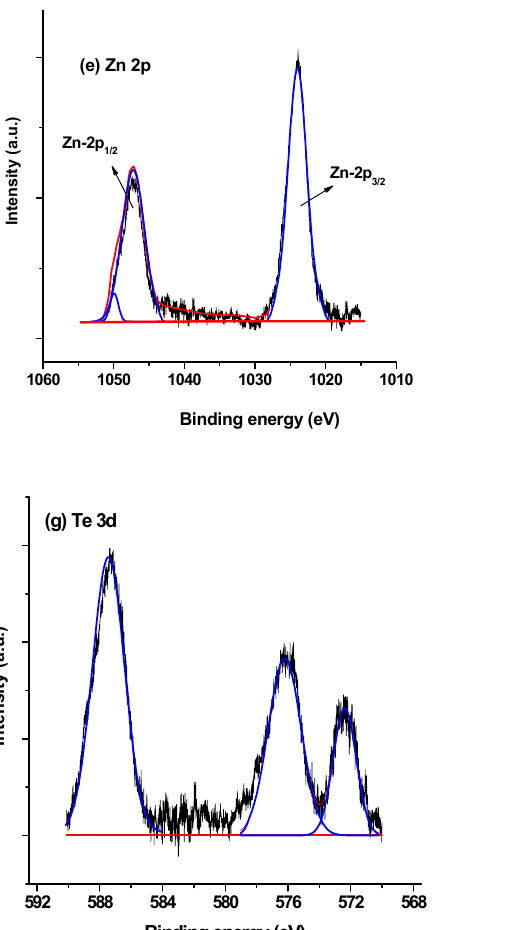
film. The as-deposited ZnTe thin films’ deconvoluted O1s peaks (in terms of Gaussian fit)